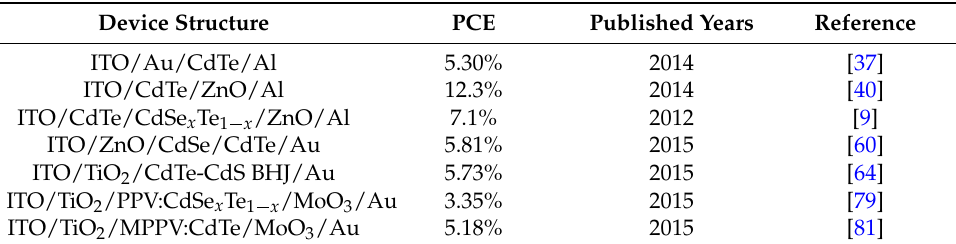
Table 2. Selected champion CdTe NC solar cell